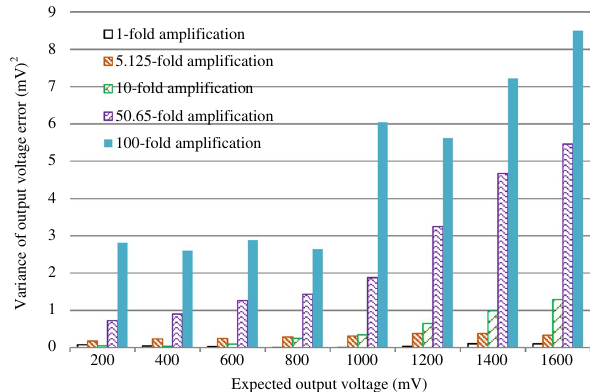
Figure 14. Analysis graph of input response variance within 1/2 ran.